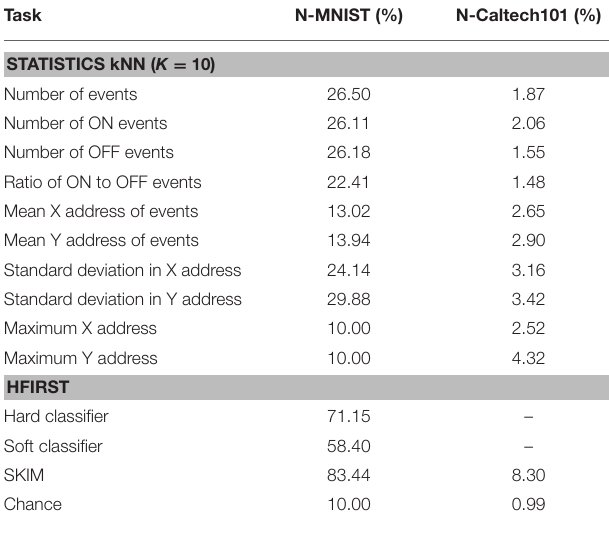
TABLE 4 | Classification accuracies for N-MNIST and